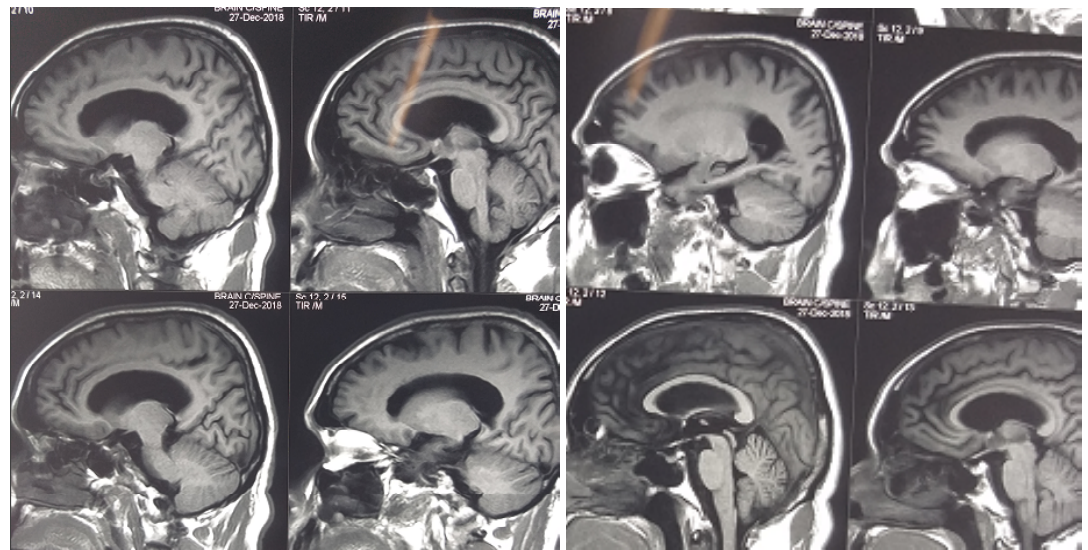
Figure 1. MRI brain showing 'sandwich sign' and hypodensity of the corpus